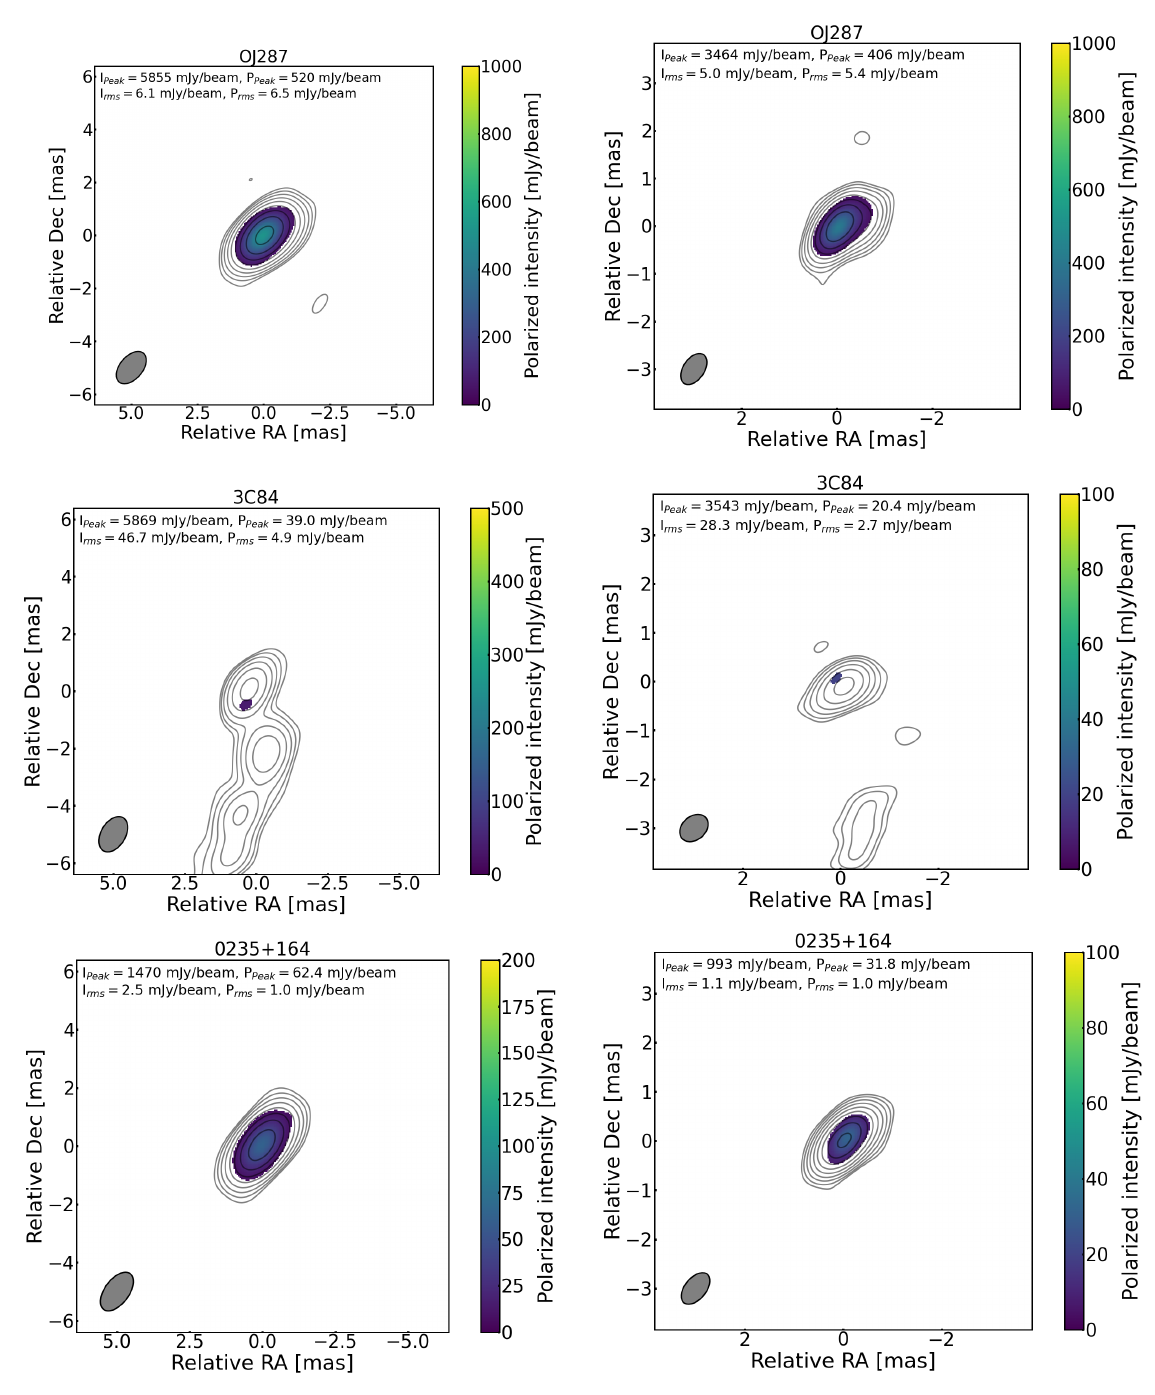
Figure 7. The 22 GHz ( left ) and 43 GHz ( right ) VERA total intensity (contour) and linearly polarized intensity (color) maps of OJ287 ( top ), 3C84 ( middle ), and 0235+164 ( bottom ). The 1 σ noise and peak values of the total and polarized intensity are shown at the top of each panel. The contours are plotted with increasing powers of two, starting from the 3 σ level. In both the 22 and 43 GHz maps, the polarized intensity is scaled up to 7 σ , with the color scale in mJy beam − 1 given in the vertical bars to the right. The synthesized beam is plotted at the bottom left in each